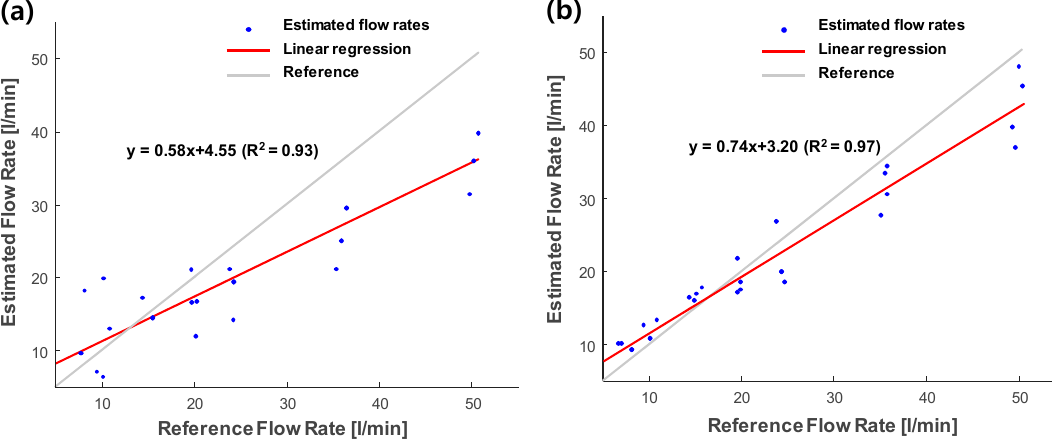
Figure 6. Estimated flow rates using ( a ) focused beam and ( b ) plane waves.